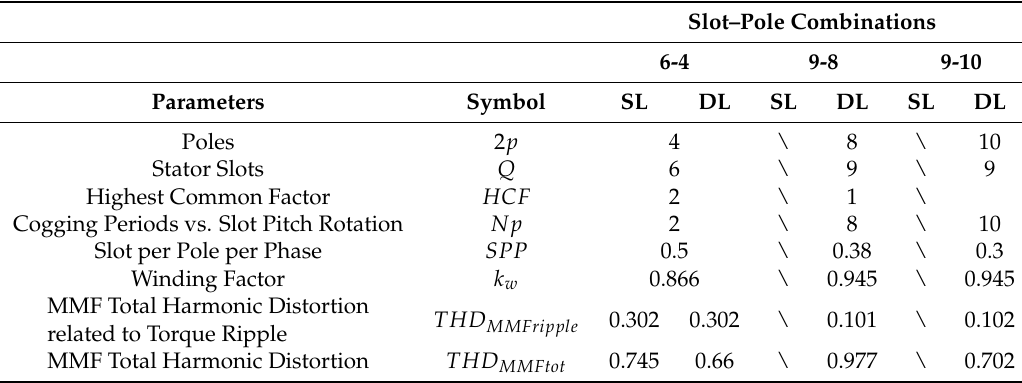
Table 2. Analyzed slot–pole combinations